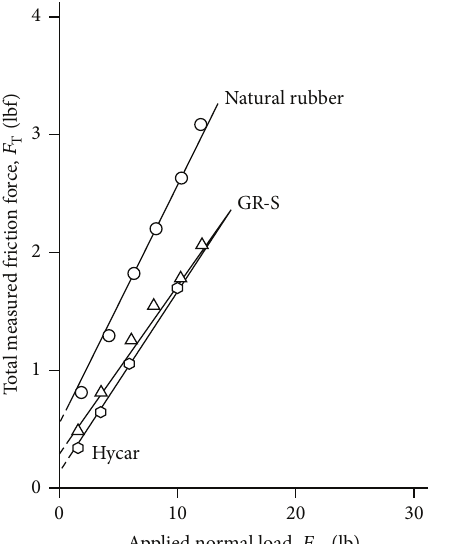
Figure 4: Results of Pfalzner’s [6] sliding friction testing of natural rubber and synthetic Hycar and GR-S on dry, macroscopically smooth ice showing generation of a microhysteretic friction force in each elastomer (from [3], CRC Press, 2008, with permission).